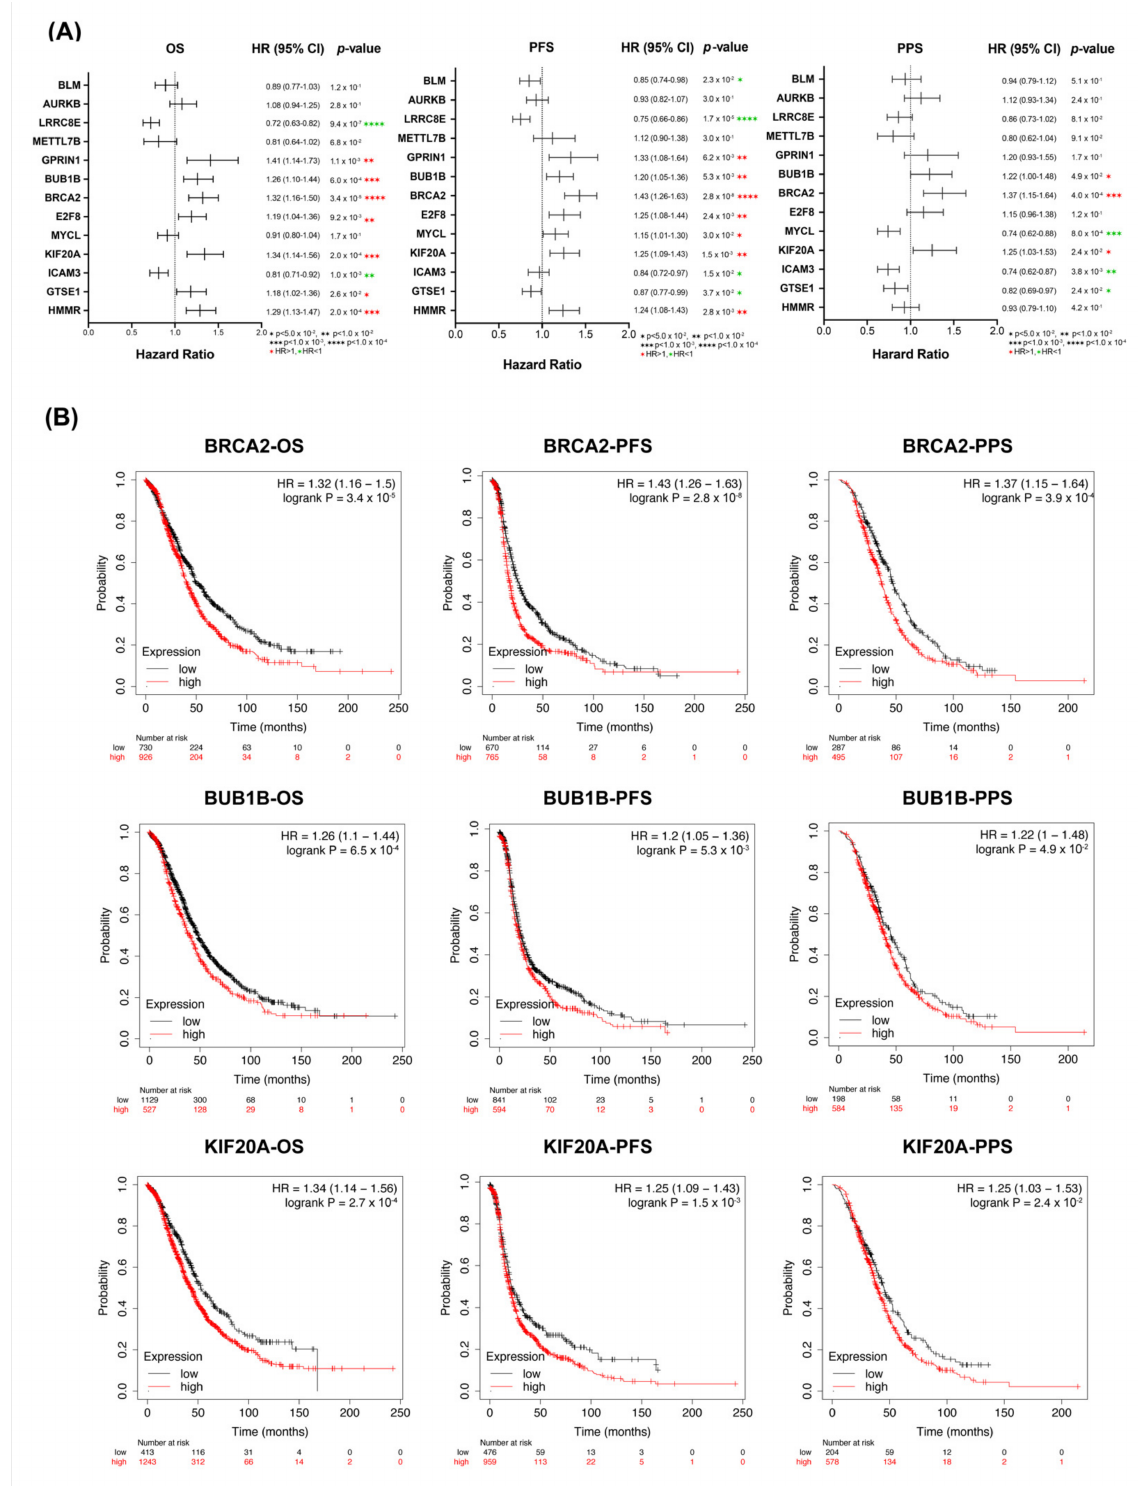
Figure 2. Prognostic values of 13 DEGs in OC. ( A ) Forest plots of 13 DEGs with survival analyses regarding OS, PFS, and PPS using TCGA-OV dataset; ( B ) survival analyses of BRCA2, BUB1B, and KIF20A regarding OS, PFS, and PPS using TCGA-OV dataset. Red, high-expression group; Black, low-expression group. p -value is log-ranked. Auto-selected best cutoff was